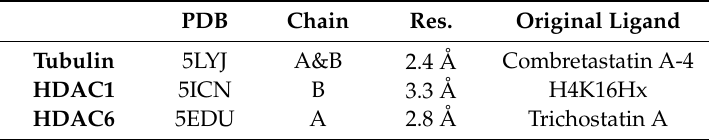
Table 7. Selection of PBD structures used for